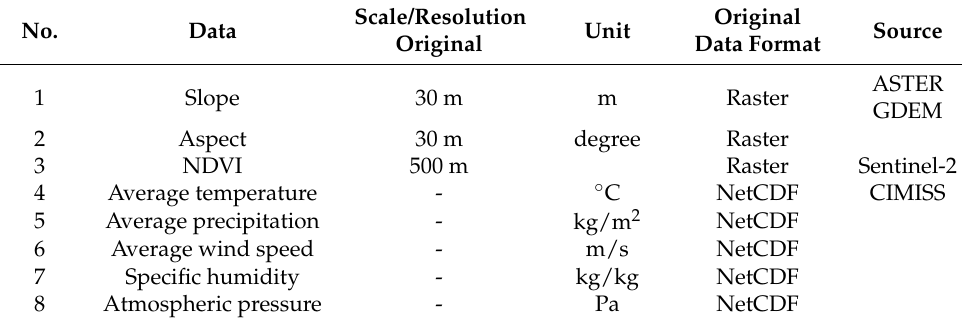
Table 1. Data description of forest fire influence. No. Data